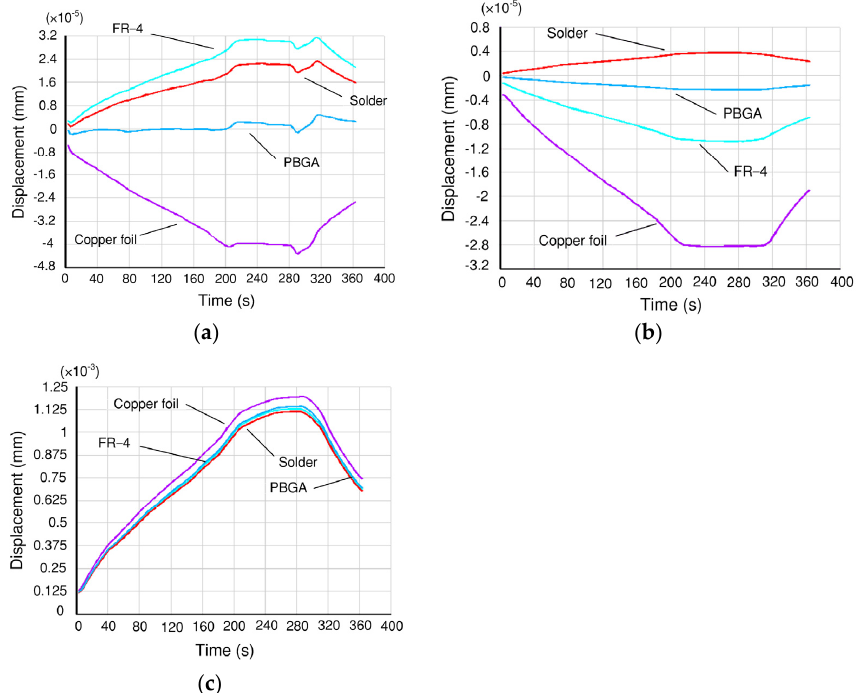
Figure 5. Displacements of the components along the different directions over time. ( a ) X direction. ( b ) Y direction. ( c ) Z direction.